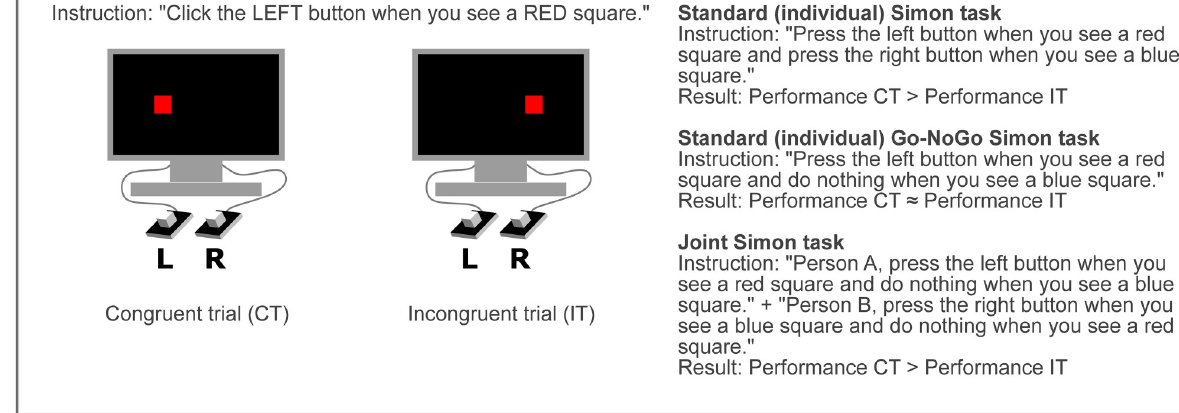
Fig 1. Button-based Simon task setup. On the left two trials are shown: a congruent trial in which the red cue is located on the same side as the required response and an incongruent trial in which the cue is located on the opposite side. On the right 3 conditions described in the main text are presented: SST, its Go-NoGo version and JST with their example instructions and typical